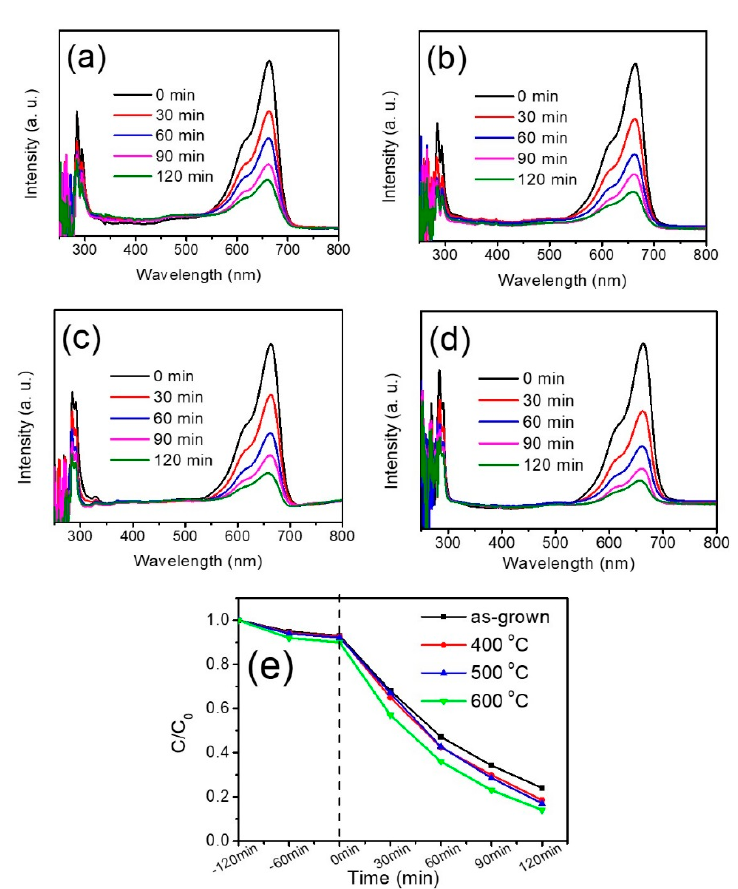
Figure 8. The intensity variation of absorbance spectra of the MB solution in presence of various WO 3 thin films under different irradiation durations: ( a ) as-grown, ( b ) 400 °C, ( c ) 500 °C, ( d ) 600 °C, ( e ) Plot of C / C 0 vs. irradiation time.